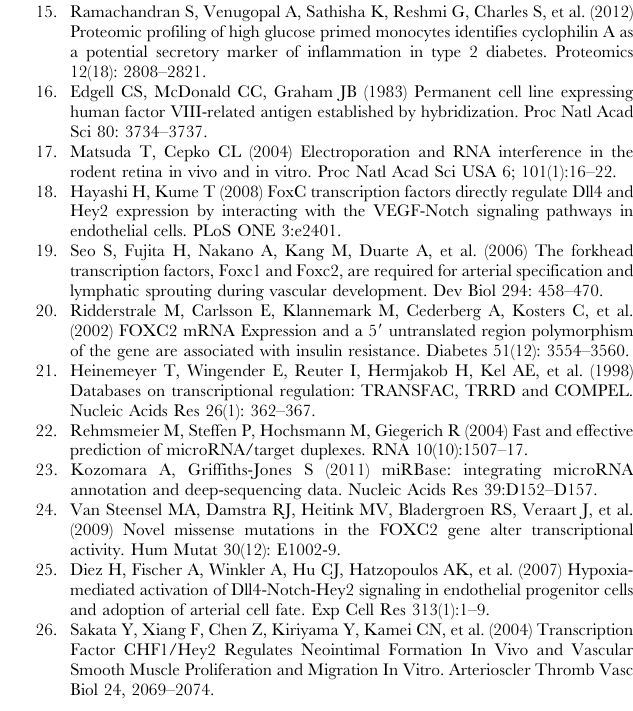
Figure S2 FoxC2 mRNA expression in vein tissues from patients with CVD. Relative FoxC2 mRNA levels in vein tissues from patients (n= 5) carrying all the four variants such as c.-